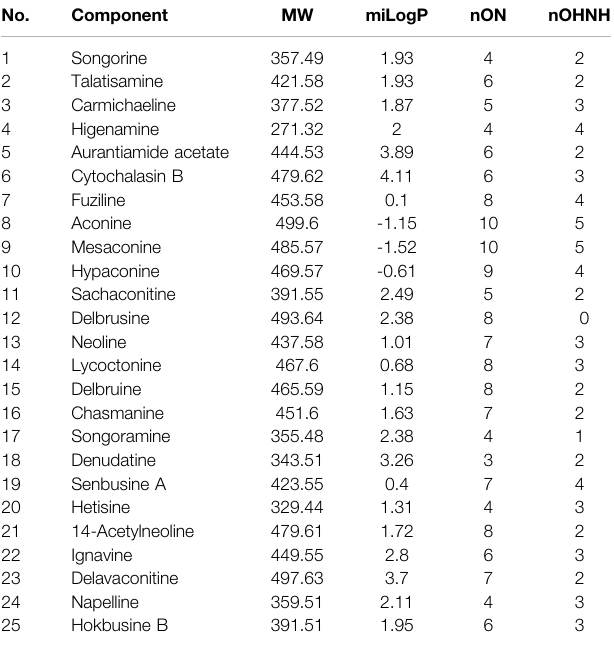
TABLE 2 | Absorption parameters of ARC